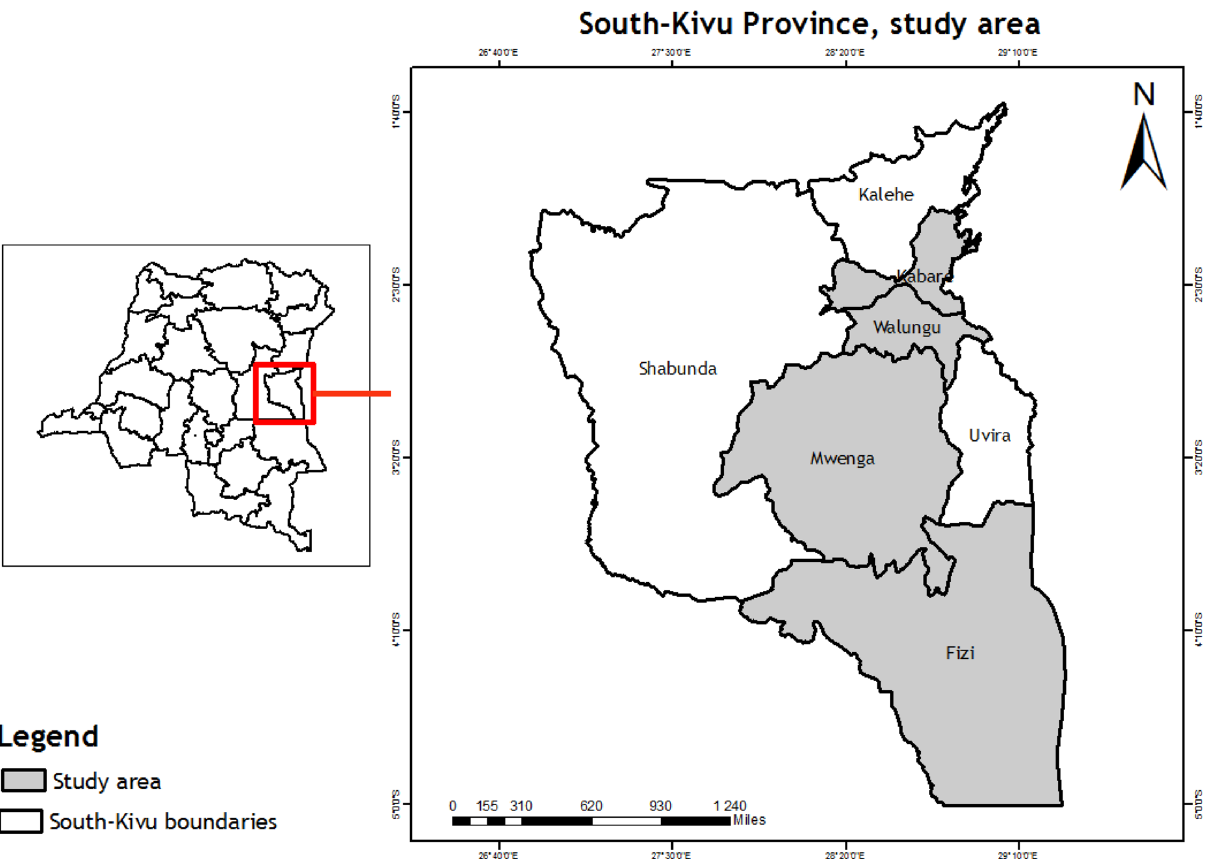
Figure 1. Map showing South-Kivu Province and the study Territories (ArcMap 10.4. https:// deskt op. arcgis. com/ en/ arcmap/